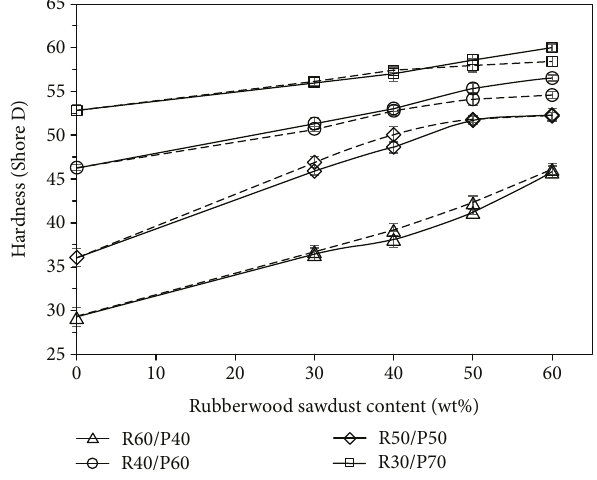
Figure 8: E ff ect of wood sawdust contents and sizes on Shore hardness for TPNR/RWS composites. Dashed lines show RWS 40 mesh, and solid lines represent RWS 80